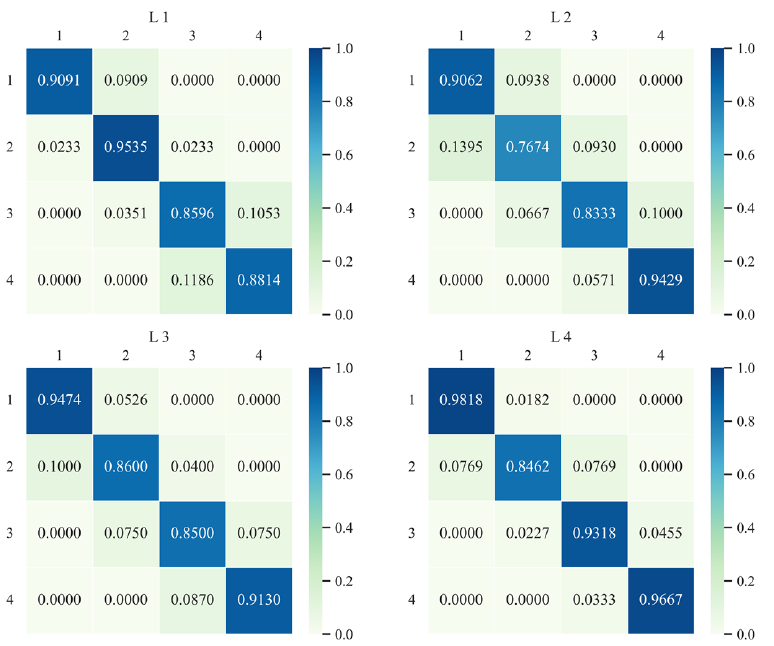
Figure 5. Spatial Markov transition probability matrix for CEI types at city level in the YRB from 2007 to 2017.